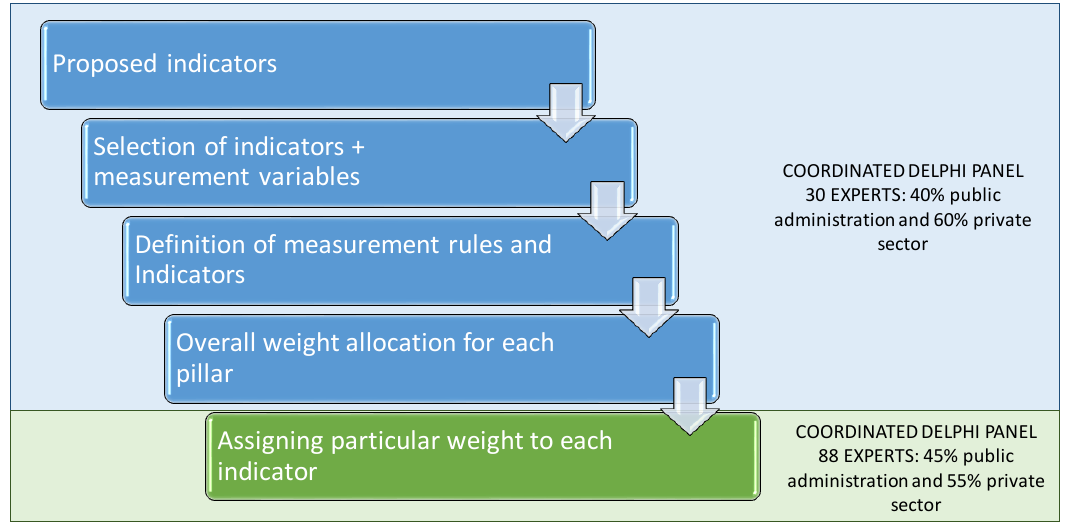
Figure 4. Process to obtain Smart Port indicator.